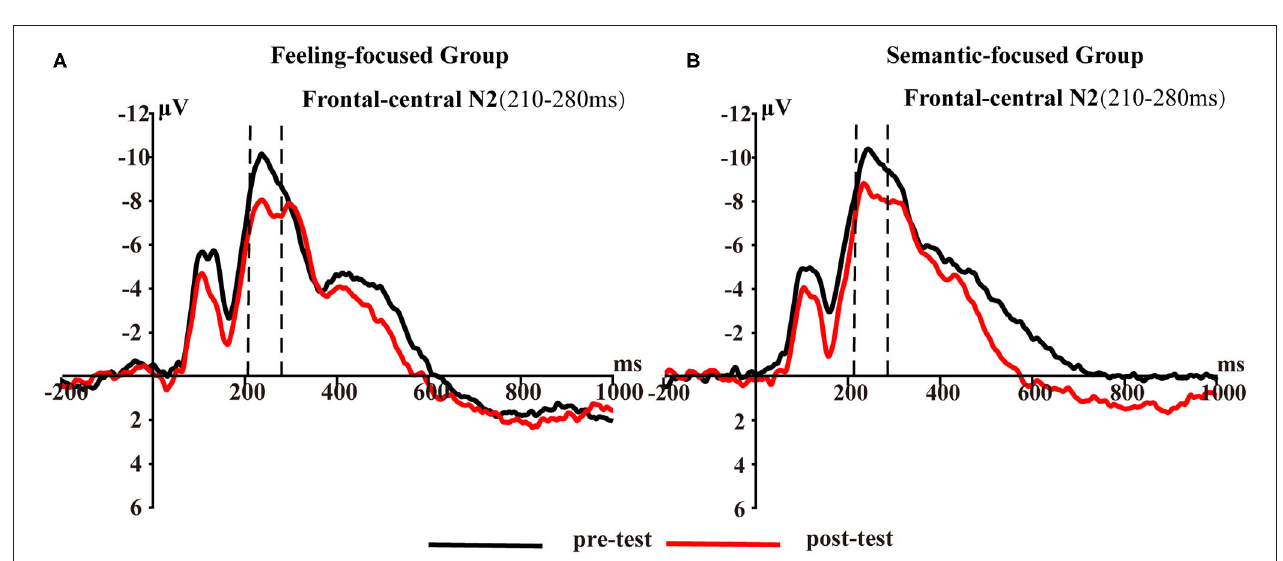
FIGURE 2 | Frontal–central N2 averaged at five frontal–central sites (FCZ, FC1, FC2, FC3, and FC4) for (A) feeling-focused group and (B) semantic-focused group in pre- and post-tests for 210–280ms.